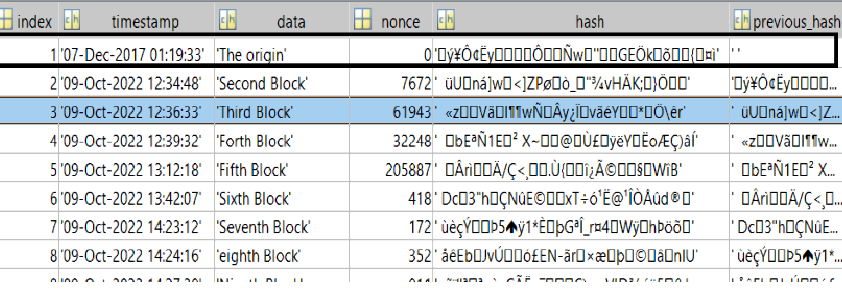
Figure A2. Shape of genesis block in the